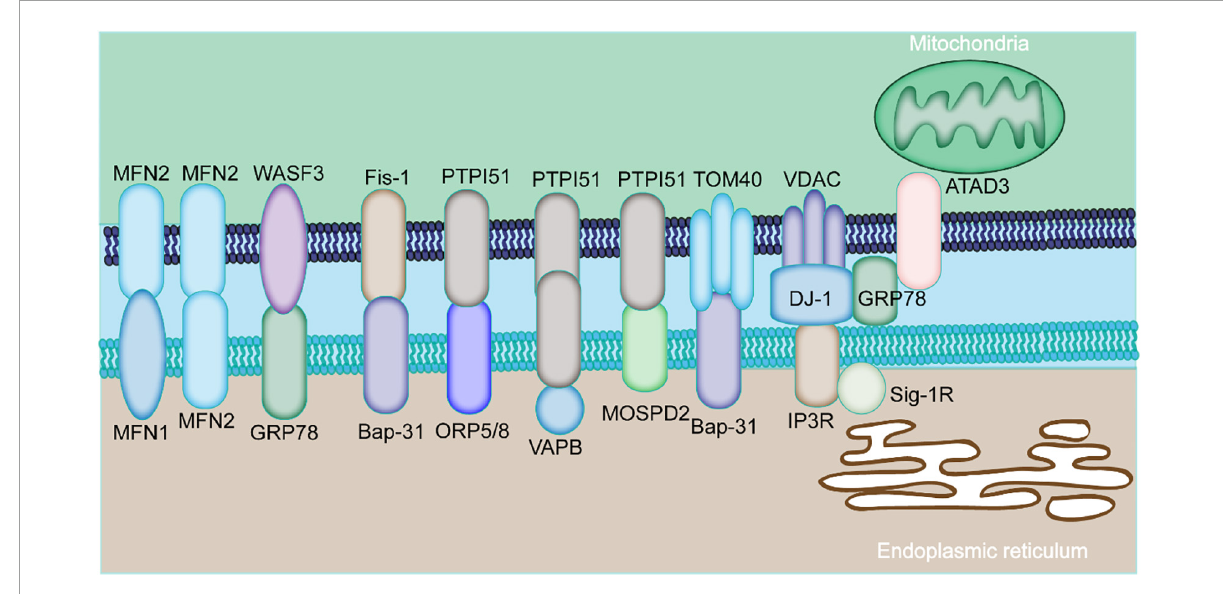
FIGURE1 Major components of MAMs proteins. The physical interaction among MAMs is mediated by various proteins expressed by MAMs. The mitochondria-localized MFN2 forms a hetero- or homo-dimer with MFN1 and MFN2 on the ER. The ER chaperone GRP78 interacts with WASF3. The ER-localized BAP31 interacts with the mitochondrial Fis1 and TOM40. The mitochondrial PTPIP51 interacts with the ER protein ORP5/8, VAPB, or MOSPD2. ER-resident IP3R is anchored to OMM-localized protein VDAC via GRP75. The ER protein, GRP78, cytoplasm-residing WASF3, the IMM localizing ATAD3A constitute the GRP78-WASF-ATAD3A